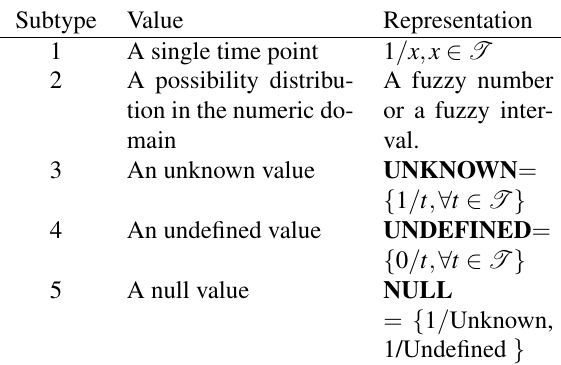
Table 6. Values for the time point data